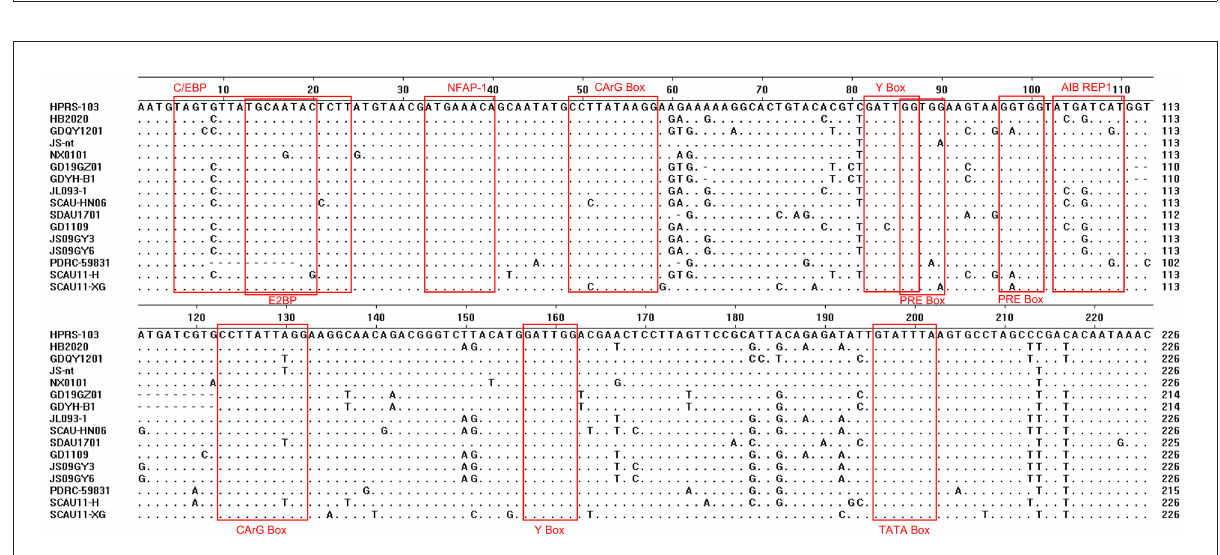
FIGURE8 Comparative analysis of the U3 region of different ALV-J strains.